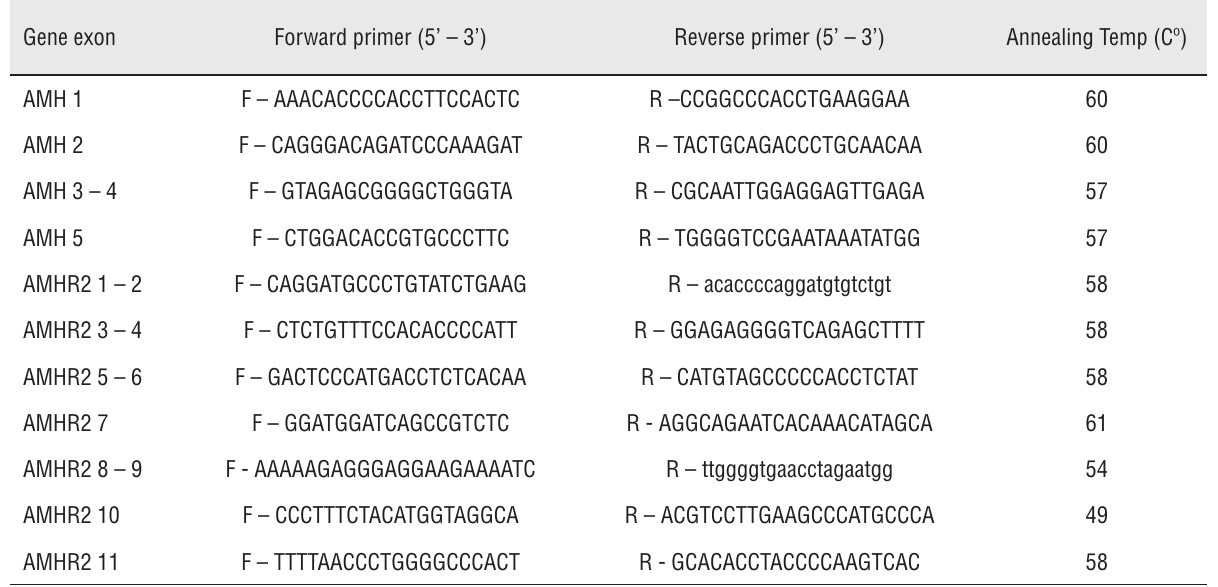
Table 1 - Primer sequences and annealing temperatures of fragments of AMH and AMHR2. Gene